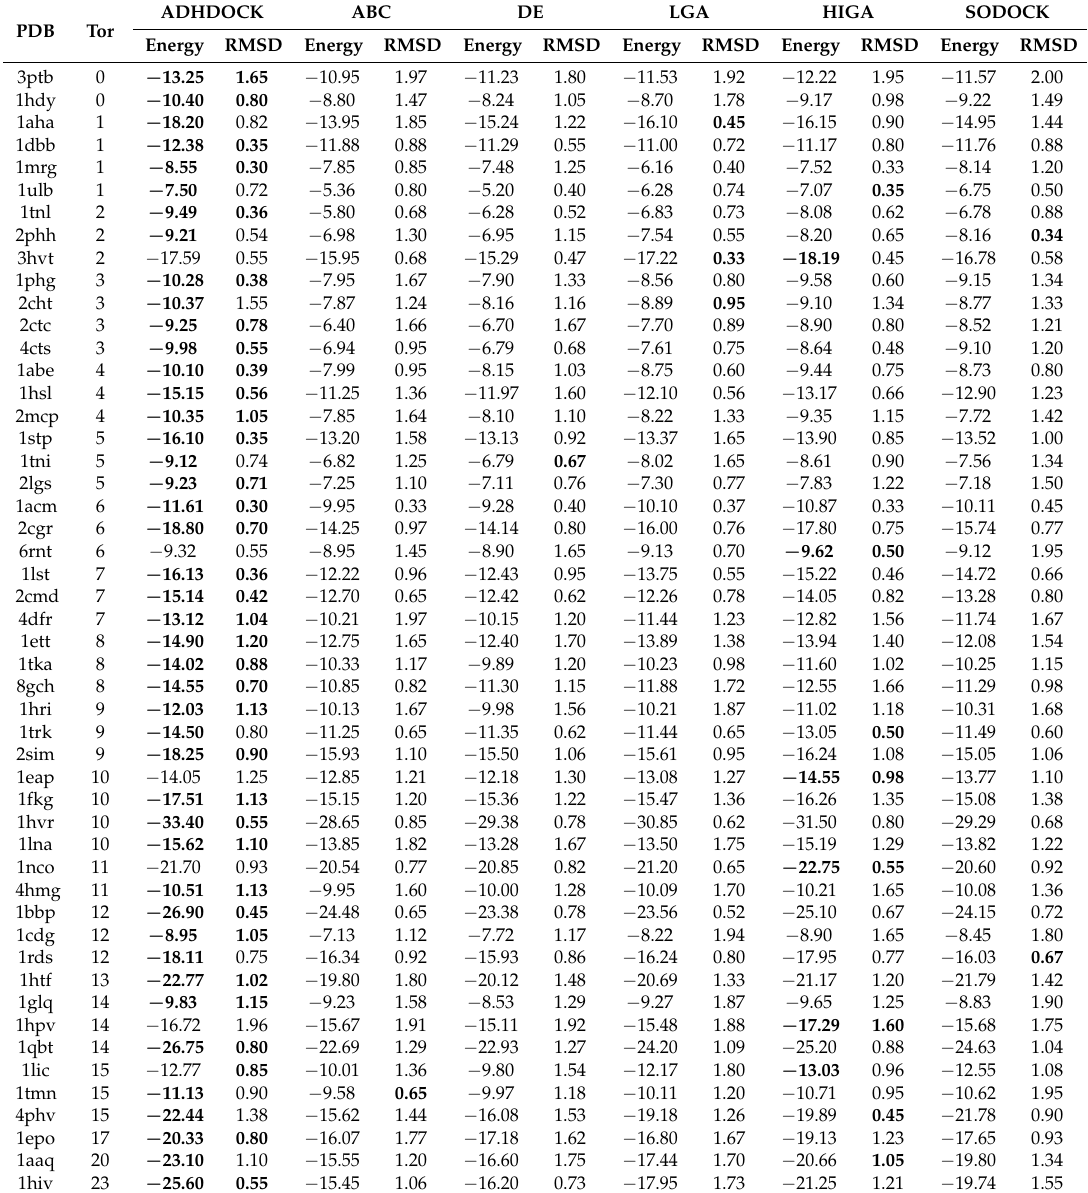
Table 3. The lowest energy and the smallest RMSD of the best predicted